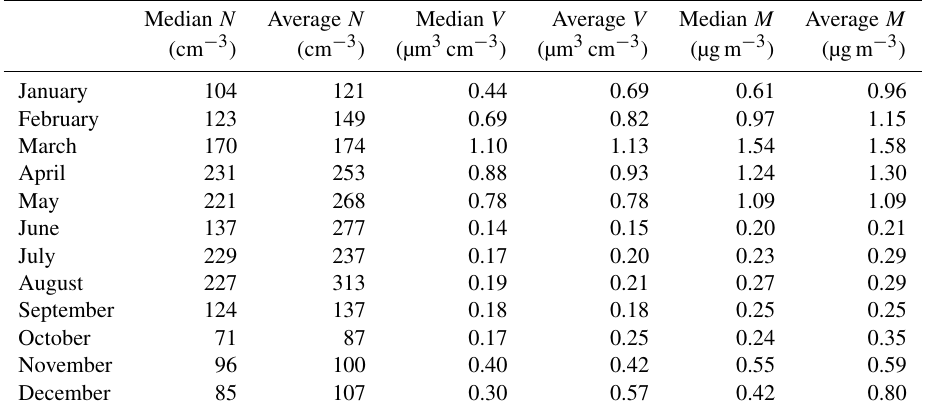
Table 2. Median and average particle number concentration ( N ), particle volume concentration ( V ) and particle mass concentration ( M ) for the 12 months of 2012. M was calculated from V , assuming a density of 1.4gcm − 3 and particle